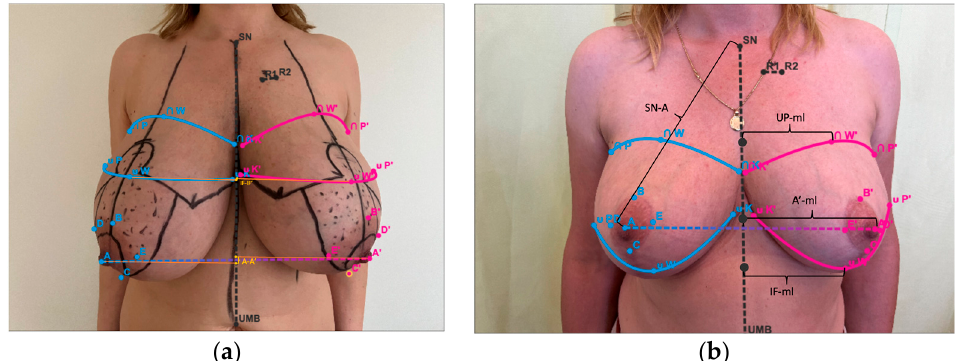
Figure 1. Breast Idea Quick Assessment: ( a ) preoperative measurements; ( b ) postoperative measurements (6 months after the surgery). Note. For better clarity of figures, differences of levels are shown only on ( a ) and measurements only on ( b ), but all variables were estimated on pre and postoperative photographs: A-A’—difference between nipple levels; IF-IF’—difference between inframammary folds levels; SN-A—nipple to sternal notch distance; IF-ml—inframammary fold apex to midline distance; UP-ml—upper pole apex to midline distance.